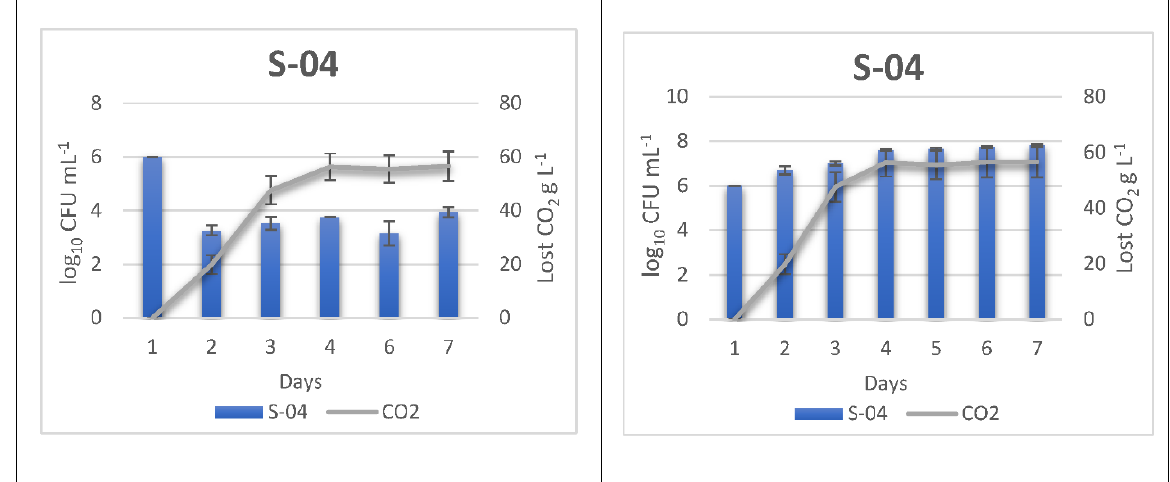
Figure 2. Fermentative kinetics and yeast monitoring of the different beers fermented sequentially with S-04 strain as control in WL medium. ( A )—Yeast viability in sequential fermentation analysed with WL medium. ( B )—Total yeast population in sequential fermentation analysed by qPCR. The data shown are the average ± standard deviations of three independent samples.